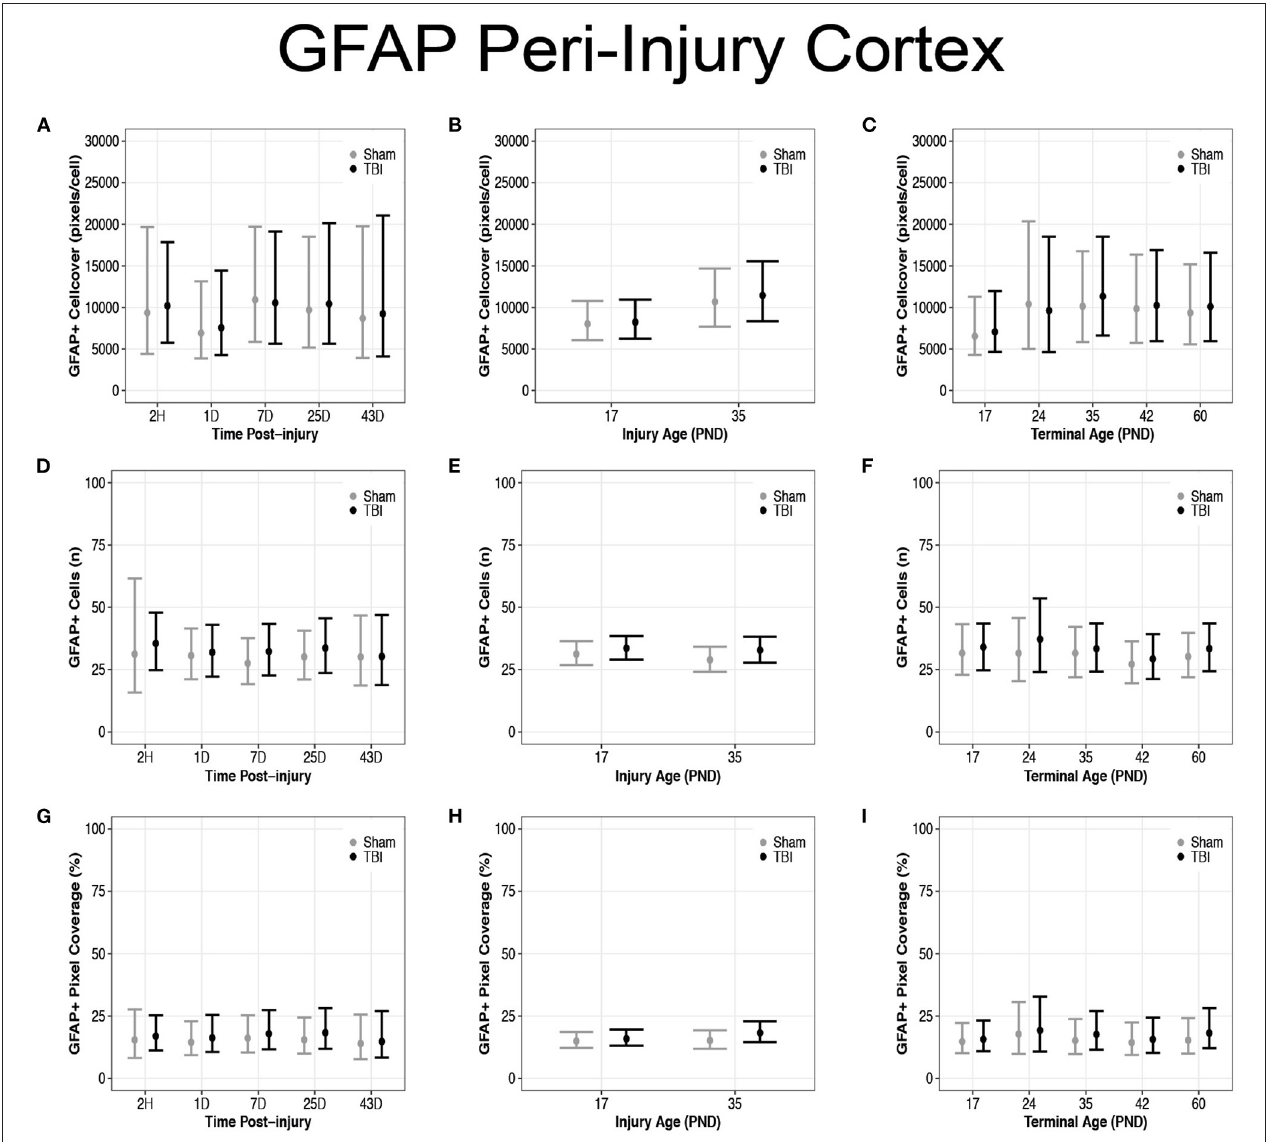
FIGURE 7 | Diffuse TBI did not affect GFAP expression in the peri-injury cortex. Point estimates (posterior means) and corresponding 95% credible intervals (highest posterior density intervals) are presented. There were no differences between sham and TBI rats across times post-injury, injury ages, or terminal ages (A–C) in cell coverage, (D–F) GFAP + cell number, (G–I) or pixel coverage